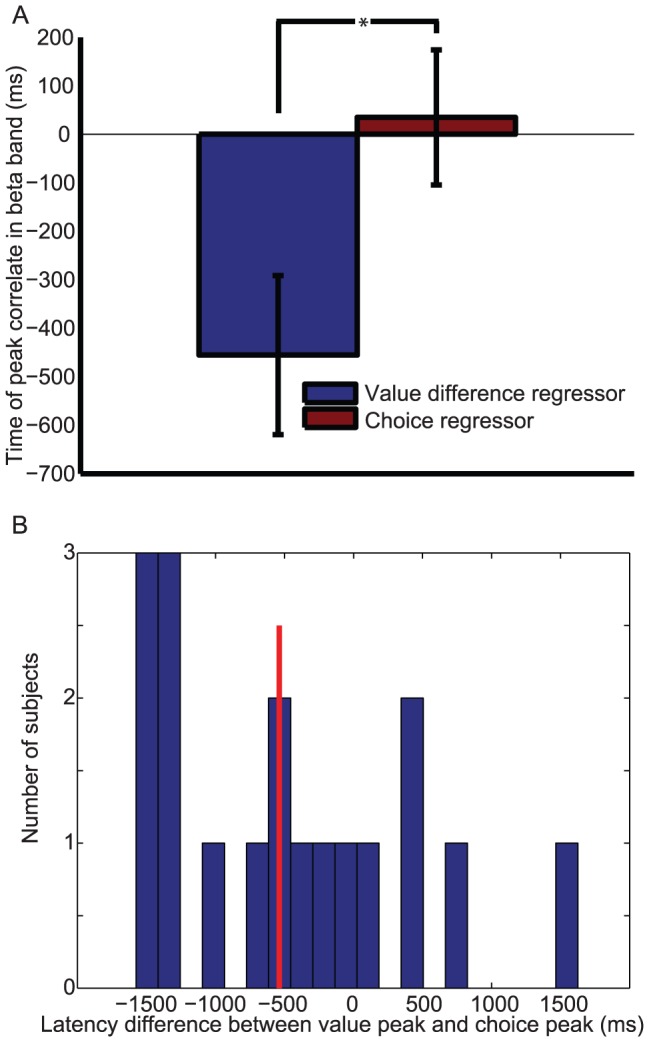
Relative latency of ‘goods value difference’ effect (in VMPFC beta synchronisation) and ‘choice’ effect (in motor cortex beta desynchronisation), timelocked to response on ‘comparison’ trials.(A) Comparison of the latency of the peak correlate of ‘value difference’ regressor in VMPFC beta synchronisation (blue) against the latency of the peak correlate of the ‘categorical choice’ regressor in motor cortex beta desynchronisation (red). * denotes p<0.05, paired T-test across 18 subjects. (B) Histogram of individual subjects' latency differences between ‘value difference’ peak latency and ‘categorical choice’ peak latency; red line denotes median latency across subjects.